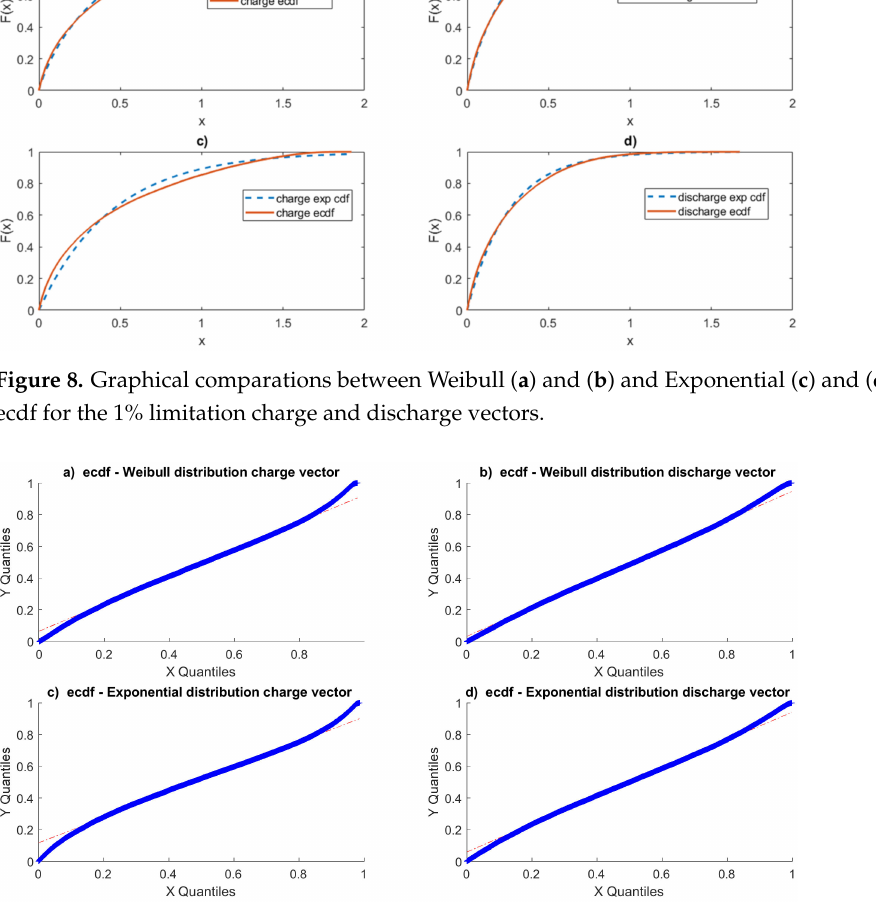
Figure 9. Q-Q plot of charge and discharge vectors comparing the ecdf with the Weibull ( a , b ) and Exponential ( c , d ) distributions.